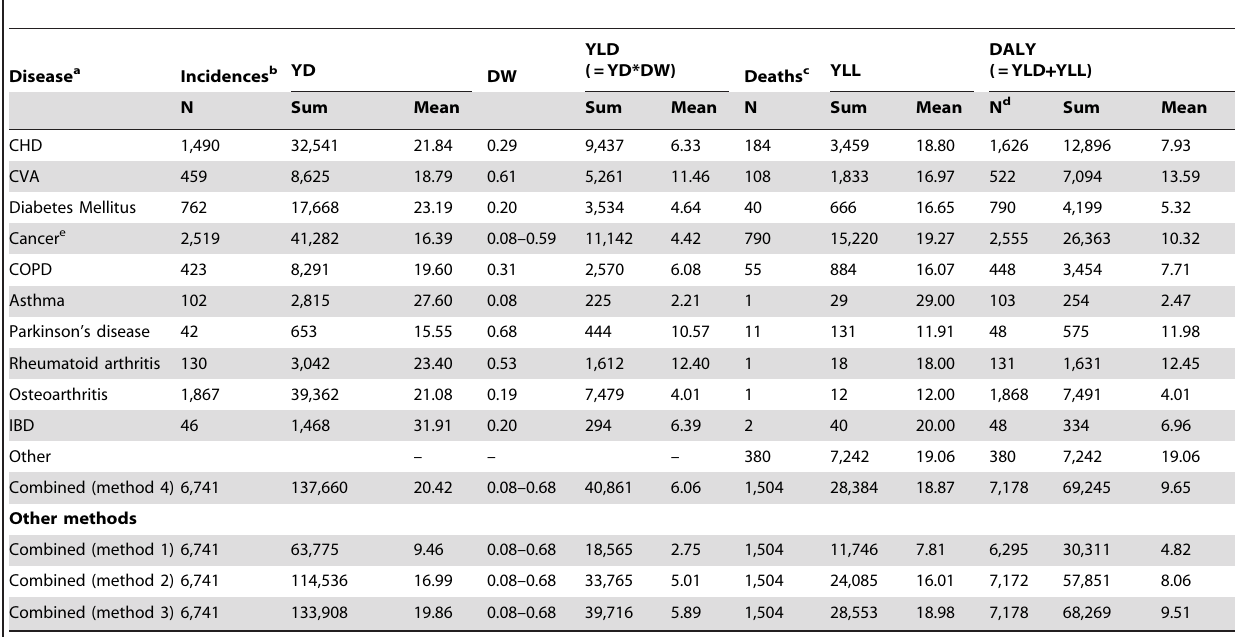
Table 1. Years Lost due to Disease (YLD), Years of Life Lost (YLL) and Disability-Adjusted Life Years (DALYs) of all EPIC-NL participants (N= 33,507).